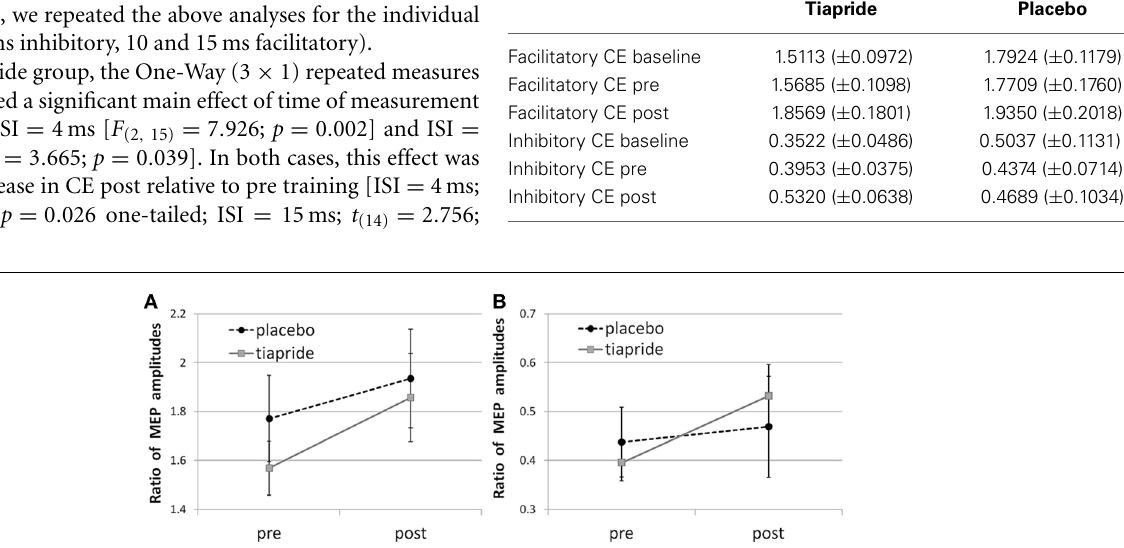
response to (A) facilitatory double pulse/single pulse stimulation and (B) inhibitory double pulse/single pulse stimulation pre and post